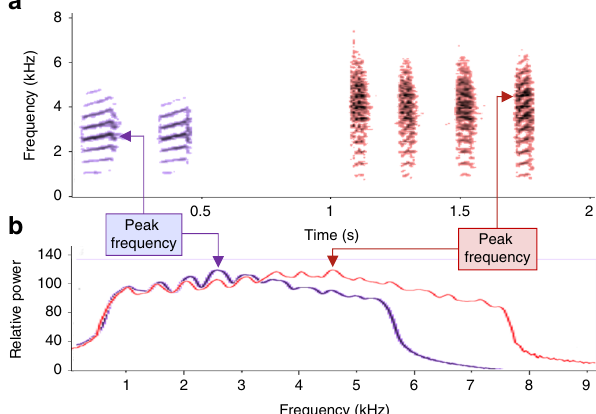
Fig. 3 Visual representation of nuthatch and stimulus calls. A spectrogram ( a ) and a power spectrum ( b ) of red-breasted nuthatch mobbing calls in response to low (left) and high (right) threat predators, illustrating the three acoustic parameters that varied with information (Linear Mixed Model: call rate interaction: χ 2 = 6.43, P = 0.011, peak frequency interaction: χ 2 = 12.78, P < 0.001, call length interaction: χ 2 = 5.57, P = 0.018; control: 38 sites, 632 calls, low- direct 19 sites, 1204 calls, high-direct: 21 sites, 5272 calls, low- indirect: 29 sites, 3172 calls, high-indirect 35 sites, 5205 calls; Figs. 2, 3; Supplementary Movie 1; Supplementary Table 1; Supplementary Data 1). There were no order:exemplar effects (Linear Mixed Model: call rate: χ 2 = 4.12, P = 0.846; peak fre- quency: χ 2 = 3.30, P = 0.914; call length: χ 2 = 10.42, P = 0.237; Supplementary Table 1; Supplementary Data 1).